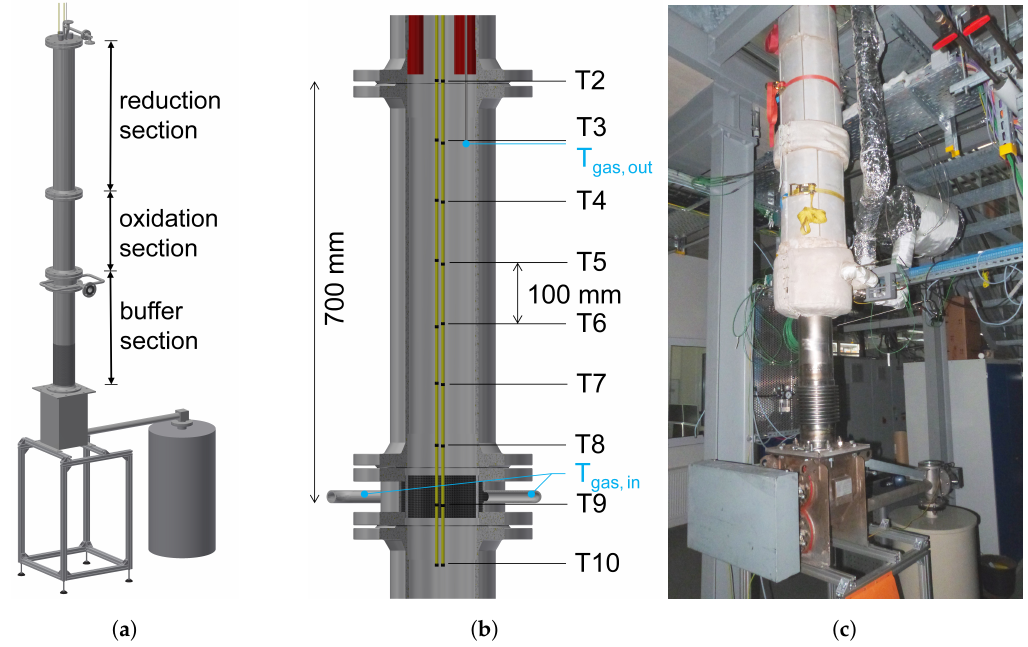
Figure 2. ( a ) Schematic of the reactor setup. ( b ) Close-up of the oxidation section with temperature measurement points. ( c ) Picture of assembled